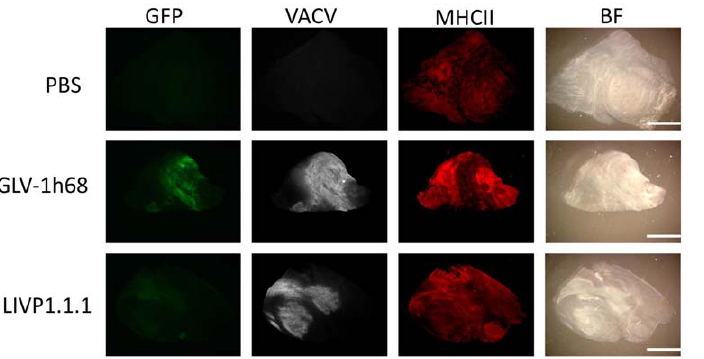
Figure 9. Immunohistochemical staining of infected and uninfected STSA-1 xenograft tumors at 21 dpvi. Tumor-bearing mice were either mock treated (PBS) or infected with GLV-1h68 or LIVP1.1.1. Tumor sections were labeled either with anti-vaccinia virus (VACV, grey) or anti- MHCII antibodies (red). GLV-1h68 infection and/or phagocytosis was indicated by GFP fluorescence (green). In addition, bright-field transmission images (BF) of all tumor sections are shown. Scale bars, 2.5 mm.